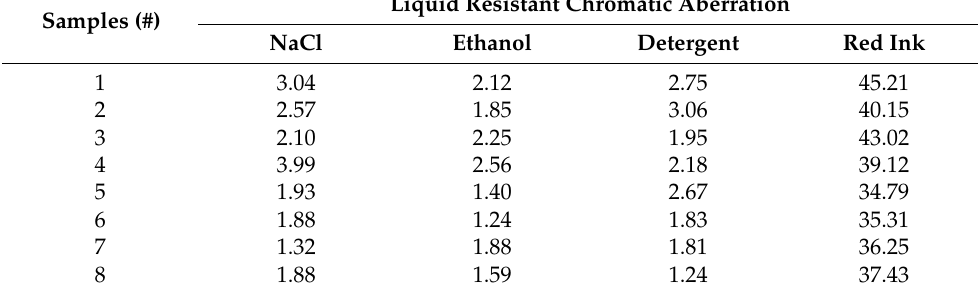
Table 6. Influence of coating processes on liquid resistant chromatic aberration of waterborne coating containing microcapsules.